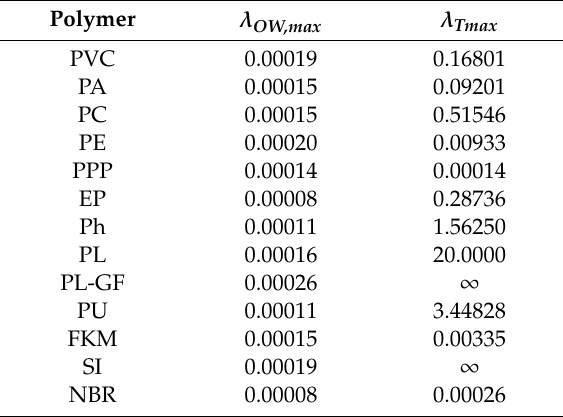
Table 5. λ OW,max and λ Tmax calculation.